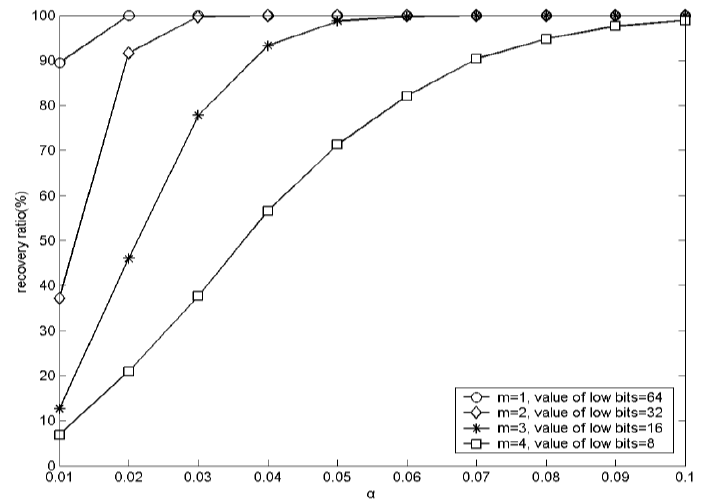
Figure 5. Recovery accuracies of the secret text T with different values of α by using Lena as the host